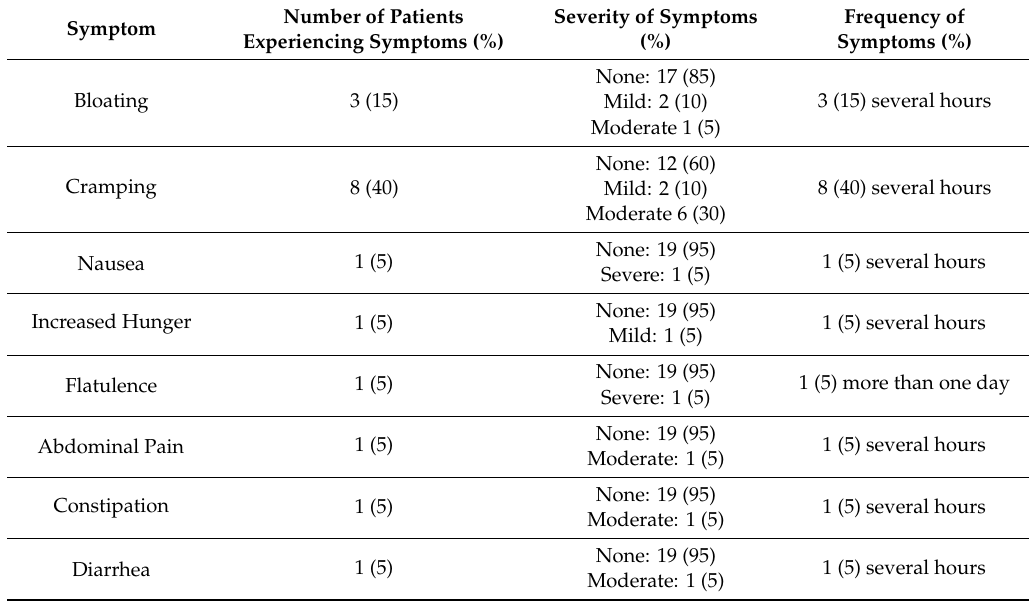
Table 7. Symptoms in subjects treated with